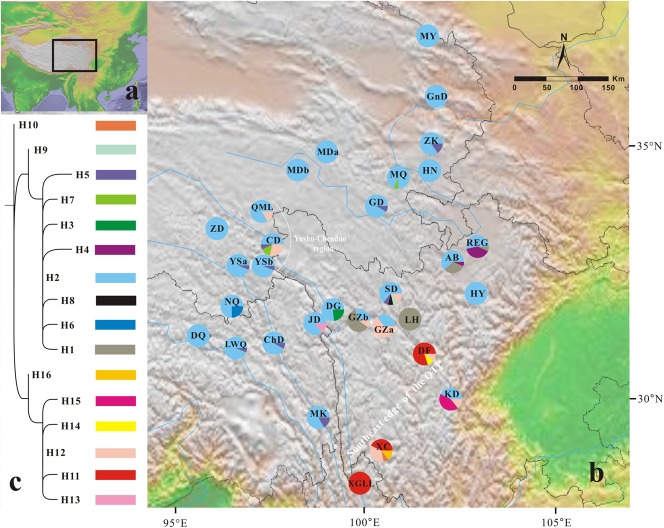
Geographical distribution of 16 chloroplast haplotypes (H1–H16) identified in Gentiana lawrencei var. farreri. (A) The distributions of G. lawrencei var. farreri on the Qinghai-Tibetan Plateau. (B) Geographical distribution of haplotypes across sampled populations. Pie charts display haplotype frequencies in each locality. (C) Phylogeny of the 16 chloroplast haplotypes detected in G. lawrencei var. farreri. The detailed tree with outgroups is presented in Supplementary Figure S1.